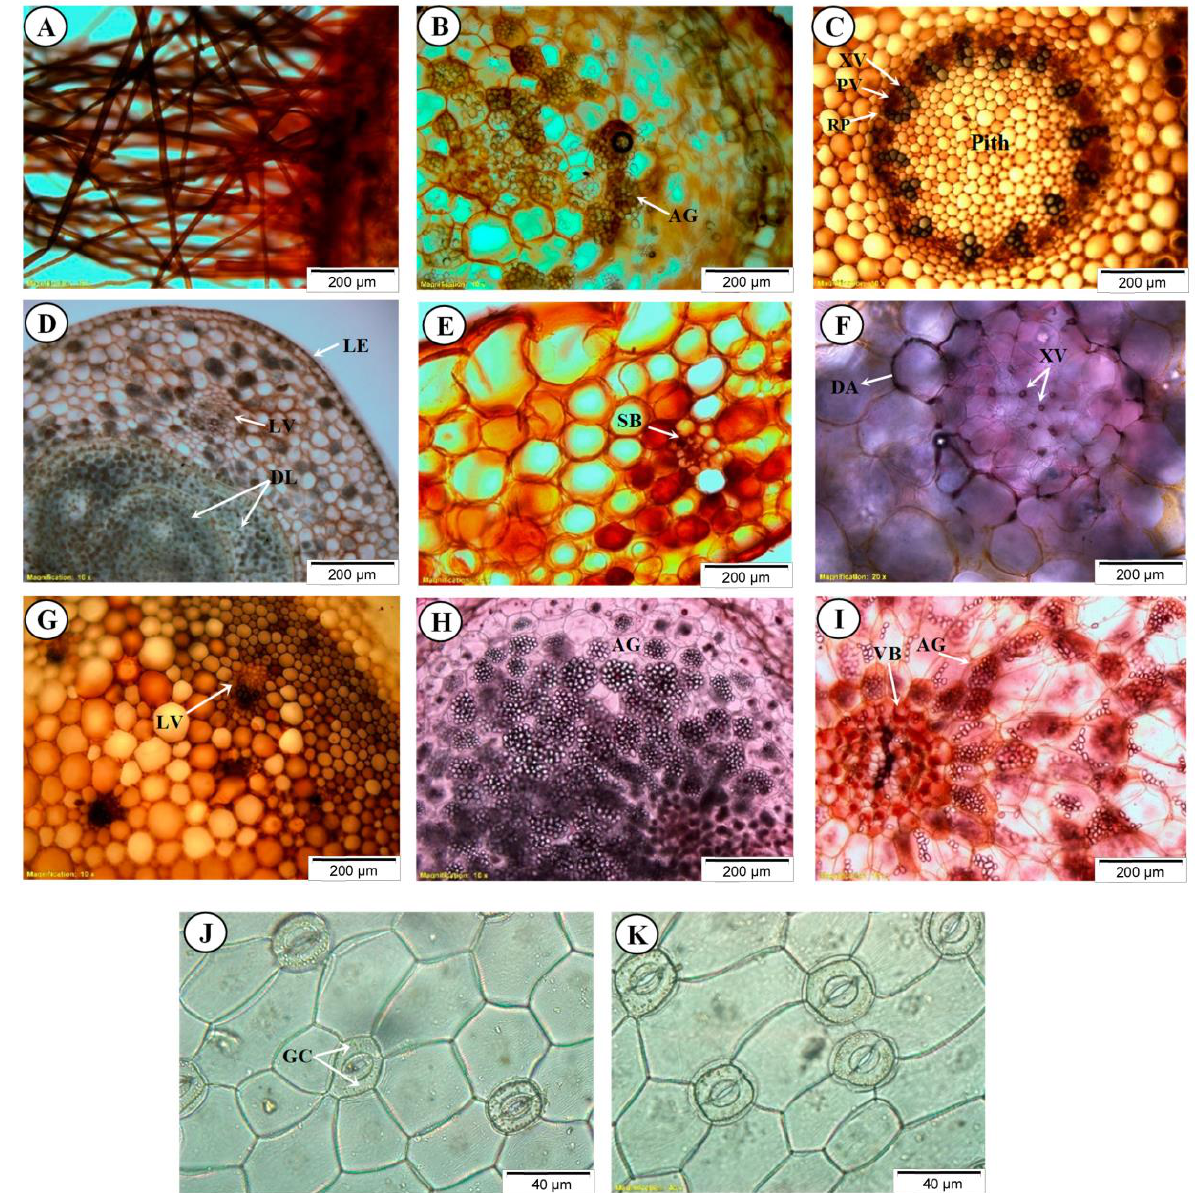
Figure 4. Histology of in vitro-raised plantlet and acclimatized and established plants of H. affine . ( A ) High-density rhizoids on PLB generated during asymbiotic seed germination. ( B ) Transverse section of root in in vitro raised plantlets showing central stele containing procambium developing vascular system. ( C ) Root histology in field-established plants showing differentiated xylem and phloem vascular elements. ( D ) Histochemical view of shoot in seedling developed under in vitro condition. ( E ) The central vascular bundle in leaf of acclimatized plant. ( F , G ) Cross-sections of stem in in vitro raised plantlets and field-acclimatized plants, respectively. ( H ) Anatomy of tuber initially formed under in vitro condition, which shows amyloplast containing starch and glucomannan. ( I ) The anatomy of tuber in well-established plants in the field. ( J , K ) The epidermis and stomata of leaf’s lower surface in in vitro-raised plantlets and field-acclimatized plants, respectively. AG, amyloplast grains; DA, developing endodermis; DL, developing leaves; GC, guard cells; LE, leaf epidermis; LV, leaf vein; PV, phloem vessels; RP, ray parenchyma; SB, single vascular bundle; VB, vascular bundle; XV, xylem vessels.